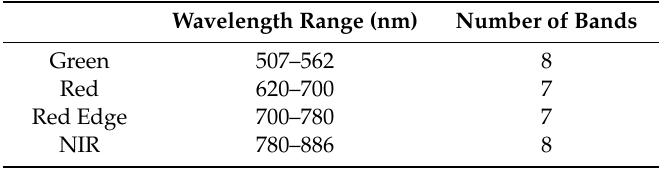
Table 5. Wavelength range and corresponding number of bands from hyperspectral